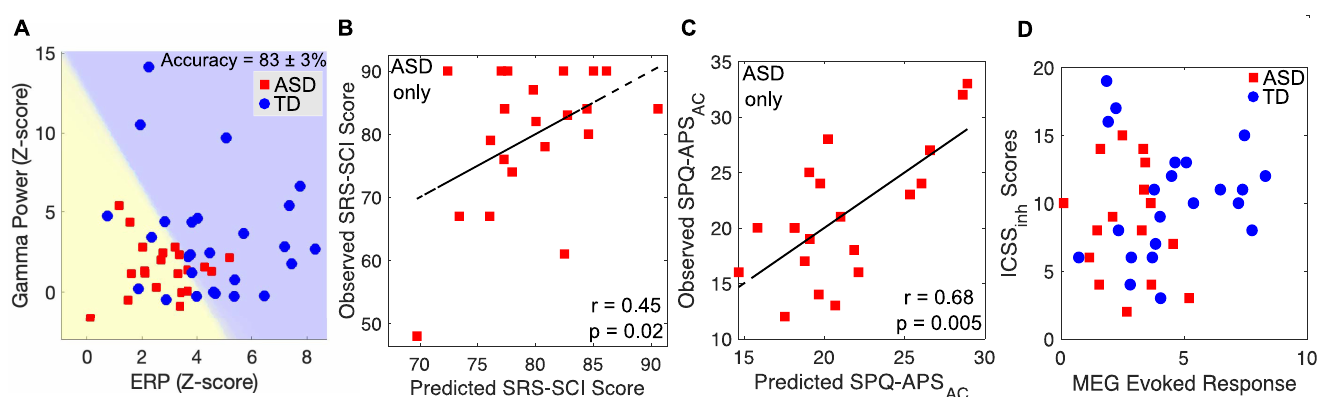
Fig 4. Behavioral correlations and group classification. (A) Group classification, using the individual evoked responses and induced gamma band activity as the inputs to the model. Yellow background depicts predicted ASD diagnosis. (B) The behaviorally assessed Social Responsiveness Scale–Social Communication and Interaction (SRS-SCI) scores, plotted against the same scores predicted by the model constructed using individual evoked responses and induced gamma band activity. (C) Same as (B), for the age-corrected Sensory Profile Questionnaire–Auditory Profile Subscale (SPQ-APS AC ) scores. (D) The averaged evoked responses for the N = 18 tones condition within the trial, plotted relative to the NEPSY-II–Inhibition Inhibition Contrast Scaled Score–Inhibition (ICSS inh ) behavioral measure, for each group. No correlation was observed between these measures. Underlying data can be found on Zenodo (doi: 10.5281/zenodo.5823656). ASD, autism spectrum disorder; MEG, magnetoencephalography; TD, typically